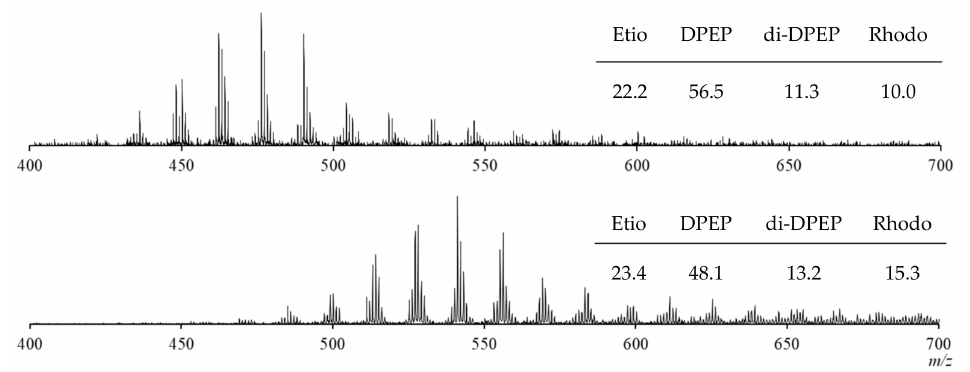
Figure 3. MALDI-TOF mass spectra of demetallated ( top ) and initial vanadyl petroleum por- phyrins ( bottom ) and their component compositions (in